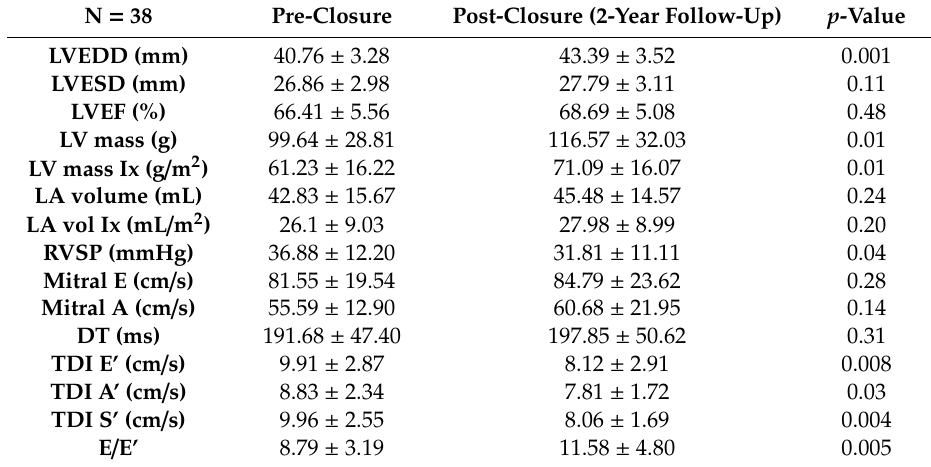
LV: left ventricle, LA: left atrium, LVEDD: left ventricular end-diastolic dimension, LVESD: left ventricular end-systolic dimension, LVEF: left ventricular ejection fraction, RV: right ventricle, RVSP: right ventricular systolic pressure, DT; Deceleration time, E; peak early inflow velocity, A; peak late inflow velocity, TDI: tissue Doppler imaging, E’; peak early diastolic velocity, A’; peak late diastolic velocity, S’: peak systolic